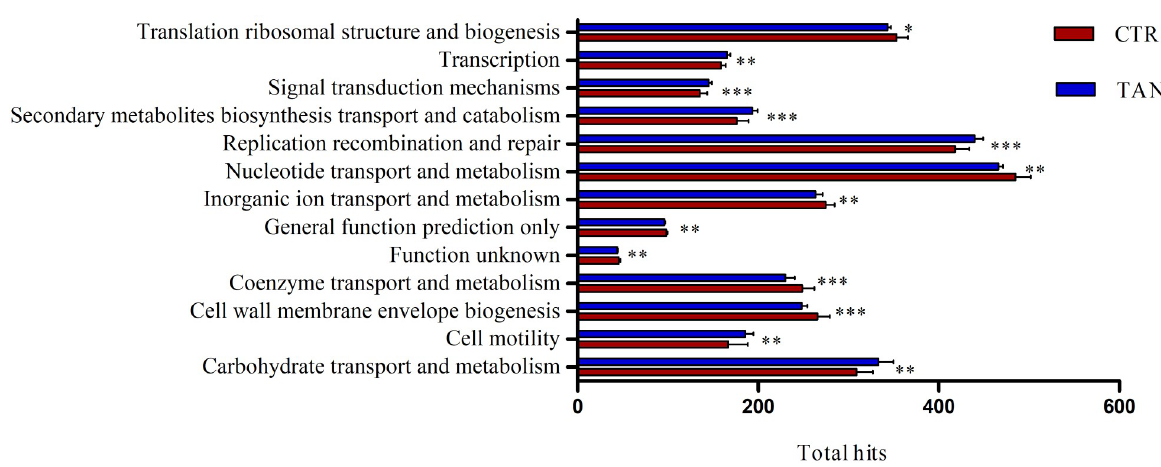
Fig 7. Significant different orthologous groups of proteins between the tannin (TAN) and control (CTR) piglets. p value significance levels were reported as � p � 0.05; �� p � 0.01; ��� p �